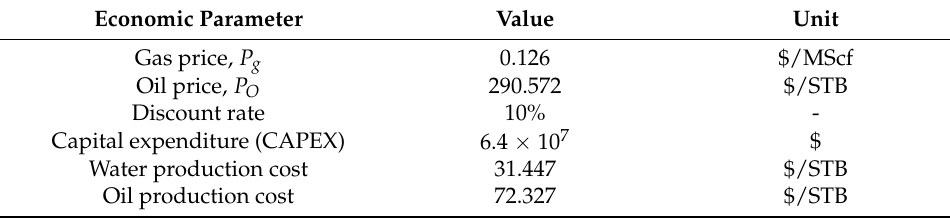
Table 5. Economic parameters used in well placement